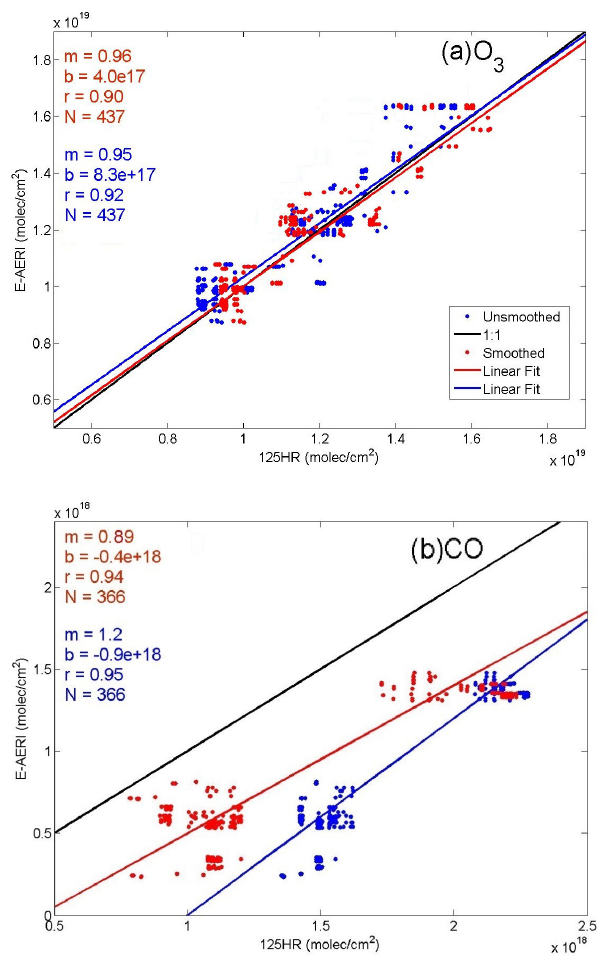
Fig. 5. Total column comparisons for E-AERI vs. 125HR (a) O 3 and (b) CO using a ± 3h coincidence criterion. The black line indi- cates the 1–1 line, the red and blue lines indicate the linear fit ( m is the fitted slope, b is the fitted y-intercept, r is the Pearson product- moment correlation coefficient, N is the number of coincidences). 125HR total columns smoothed by the monthly E-AERI averaging kernel (Fig. 4) are shown in